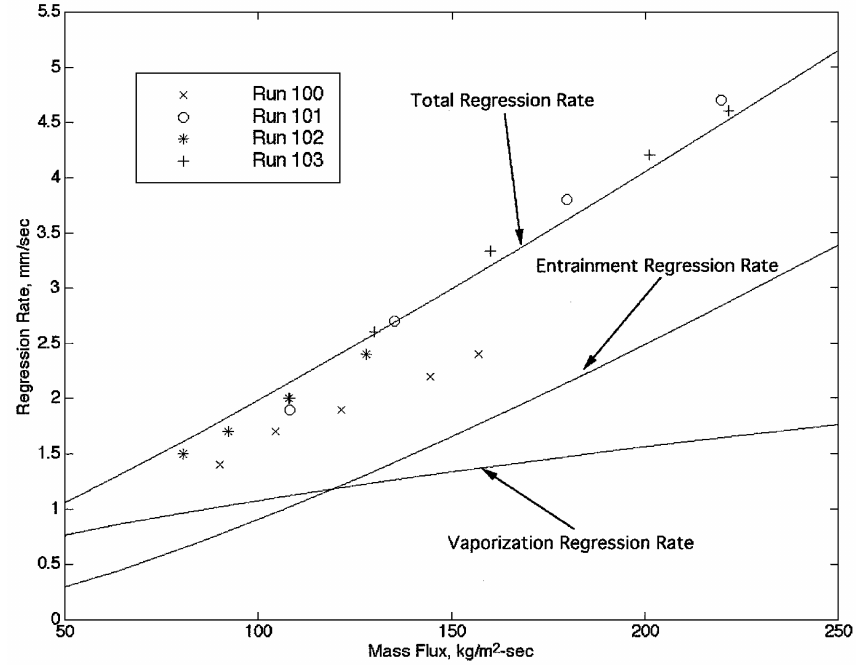
Figure 10. Plot as seen in [38], showing instantaneous regression rates and corresponding mass fluxes evaluated from the midpoint of the port for four different pentane